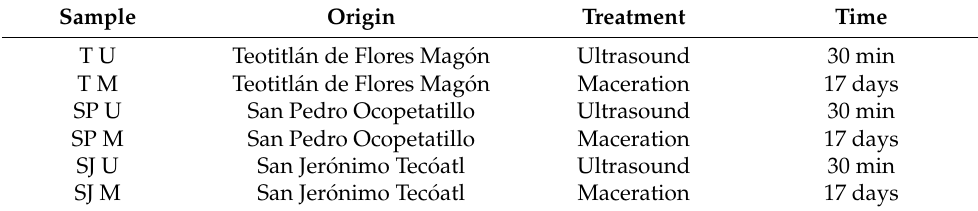
Table 1. Origin and conditions for obtaining propolis